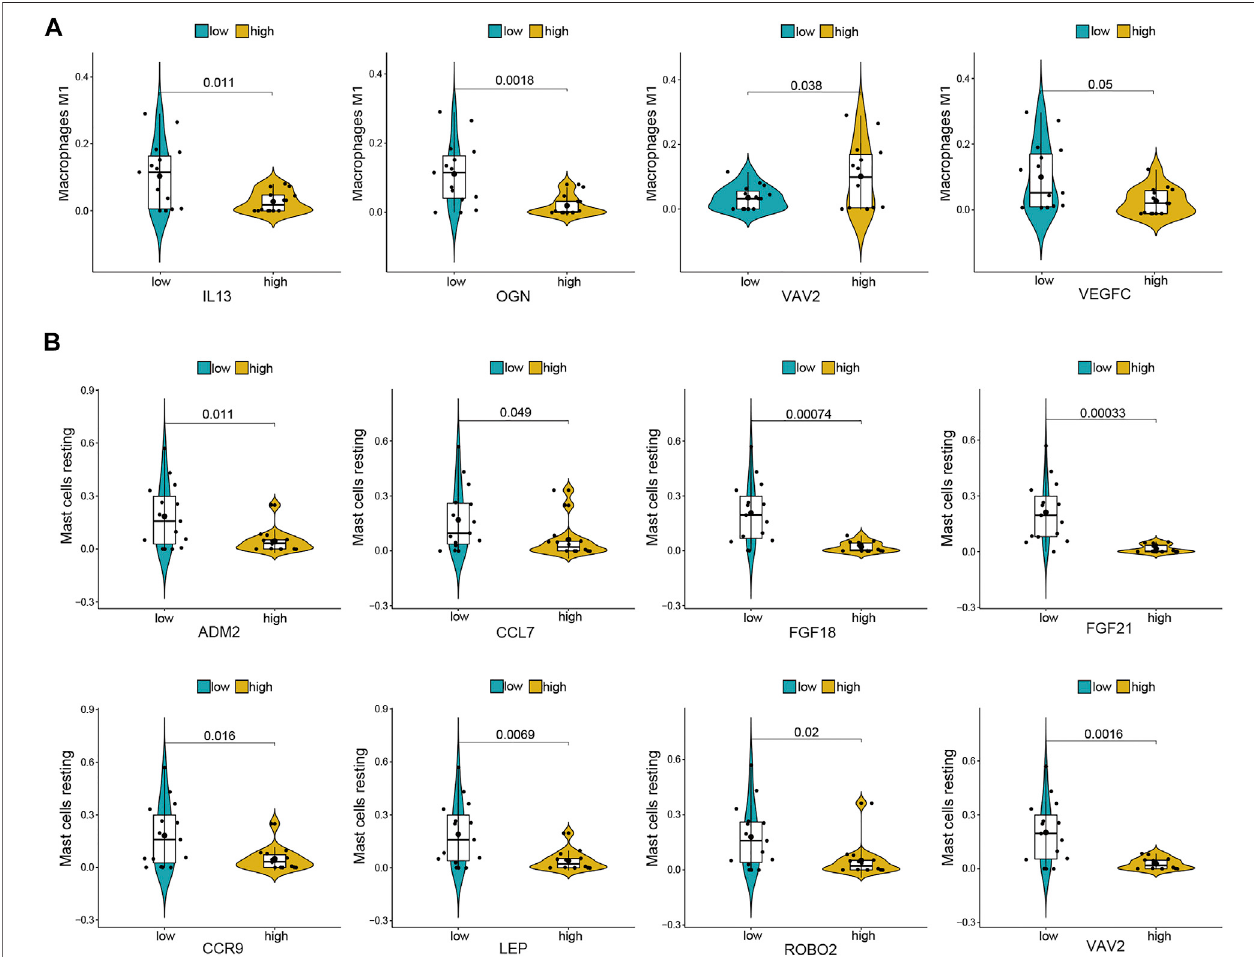
FIGURE 6 | Co-expression patterns of differential in fi ltrating immune cells and DE-mRNAs. (A) Signi fi cantly correlated pairs between M1 macrophages and DE- mRNAs. (B) Signi fi cantly correlated pairs between mast cell resting and DE-mRNAs.